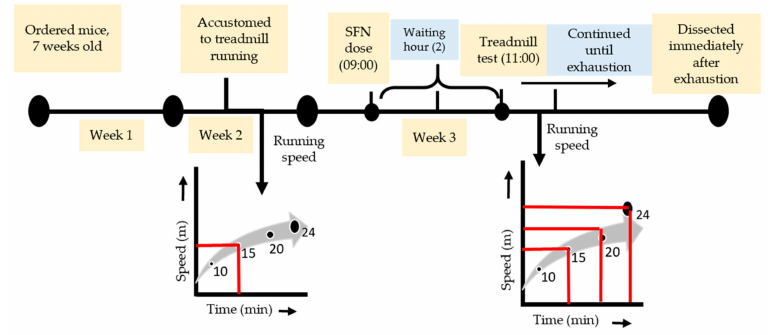
Figure 1. Experimental design and exhaustive exercise protocol.